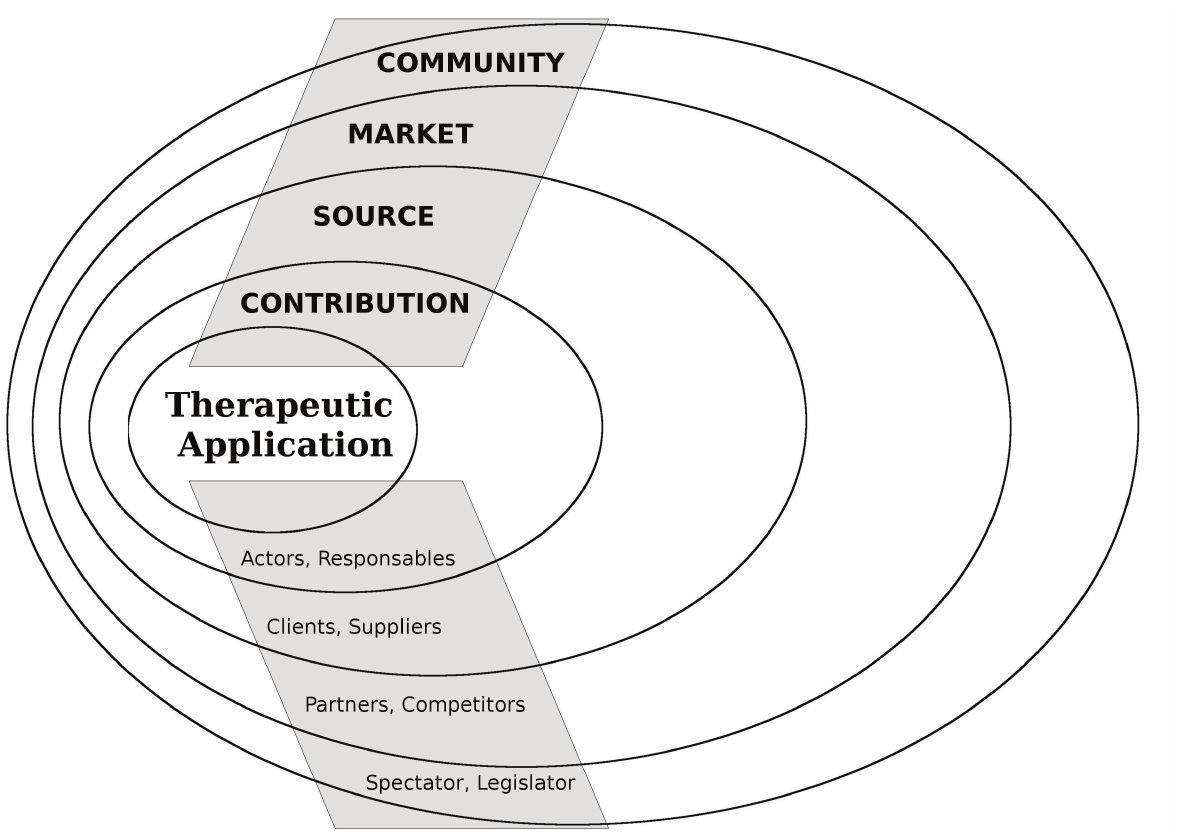
Fig. 2. Artifact for identifying the stakeholders in the design